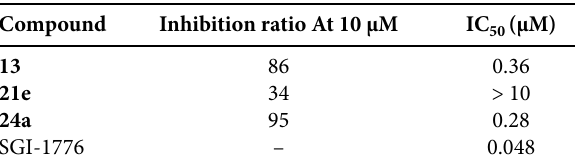
Table 5. The inhibitor activity of compounds 13 , 21e and 24a on Pim-1 Kinase. Compound